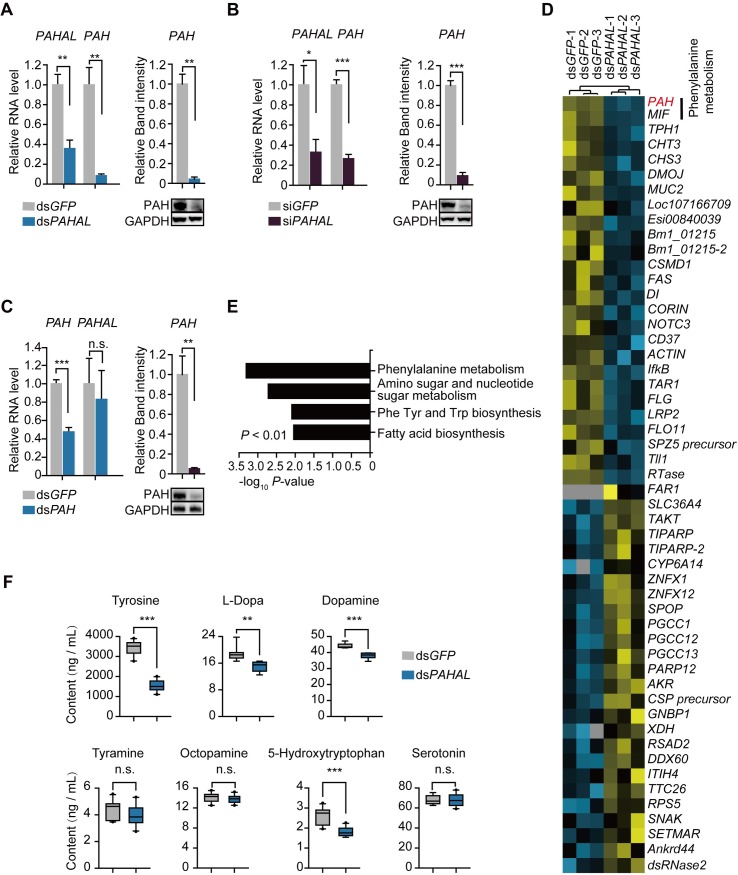
PAHAL regulates the PAH expression and controls the DA biosynthesis in the locust brain.The PAHAL and PAH expression levels in the locust brain at 72 h after dsRNA (A) and siRNA (B) knockdown of PAHAL. dsGFP and siGFP represent GFP dsRNA and siRNA injection and acts as the control. dsPAHAL and siPAHAL represent PAHAL dsRNA and siRNA injection. The expression levels in dsPAHAL and siPAHAL are normalised against those in dsGFP and siGFP. Rp49 is the internal control. Nine biological replicates of 10 brains were measured. (C) PAH knockdown through dsPAH injection did not alter the level of PAHAL. Five biological replicates of eight brains were measured. (D) Median-centered, hierarchical clustering of annotated genes that were altered in PAHAL-silenced brains. Three biological replicates of 12 brains were sequenced. (E) Functional clustering of differentially expressed genes using KEGG enrichment analysis. Only P < 0.05 terms are shown (Fisher’s exact test). (F) Effects of PAHAL knockdown on the bioamine metabolite level in the catecholamine metabolic pathway in the brain. Bioamine metabolite levels were measured through high performance liquid chromatography–mass spectrometry. Ten biological replicates of 12 brains were measured. The data in this figure, as well as those in the following figures, are represented as the mean ± SEM with the fourth-stadium nymphs, unless stated otherwise. Student’s t-test: *P < 0.05; **P < 0.01; ***P < 0.001.